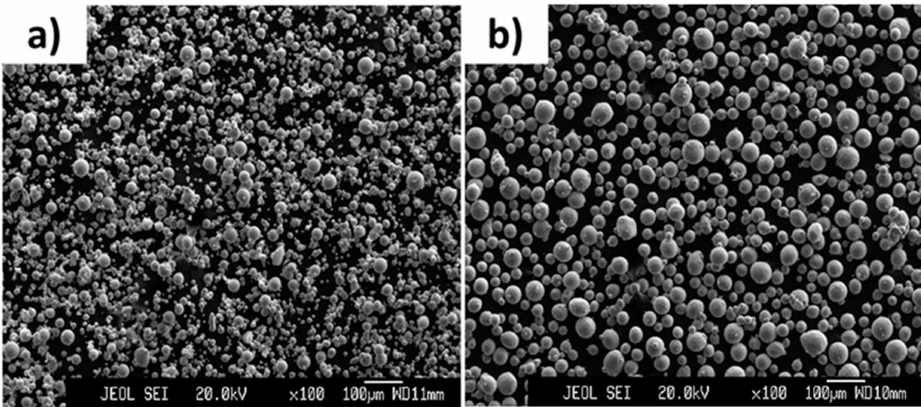
Figure 2. Images showing the microstructure of ( a ) Ni and ( b ) Ti powders.